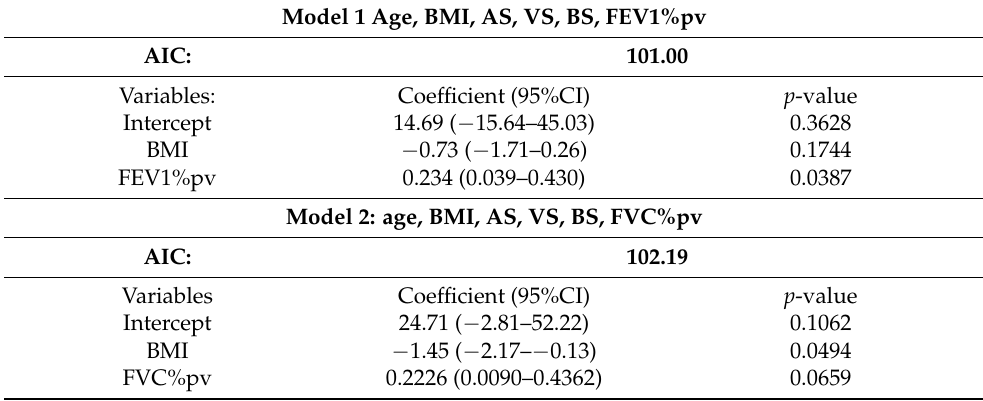
Table 5. Summary of stepwise linear regression models for predicting spirometry adherence (days with performed spirometry) with the clinical, anthropometric, and spirometry data.